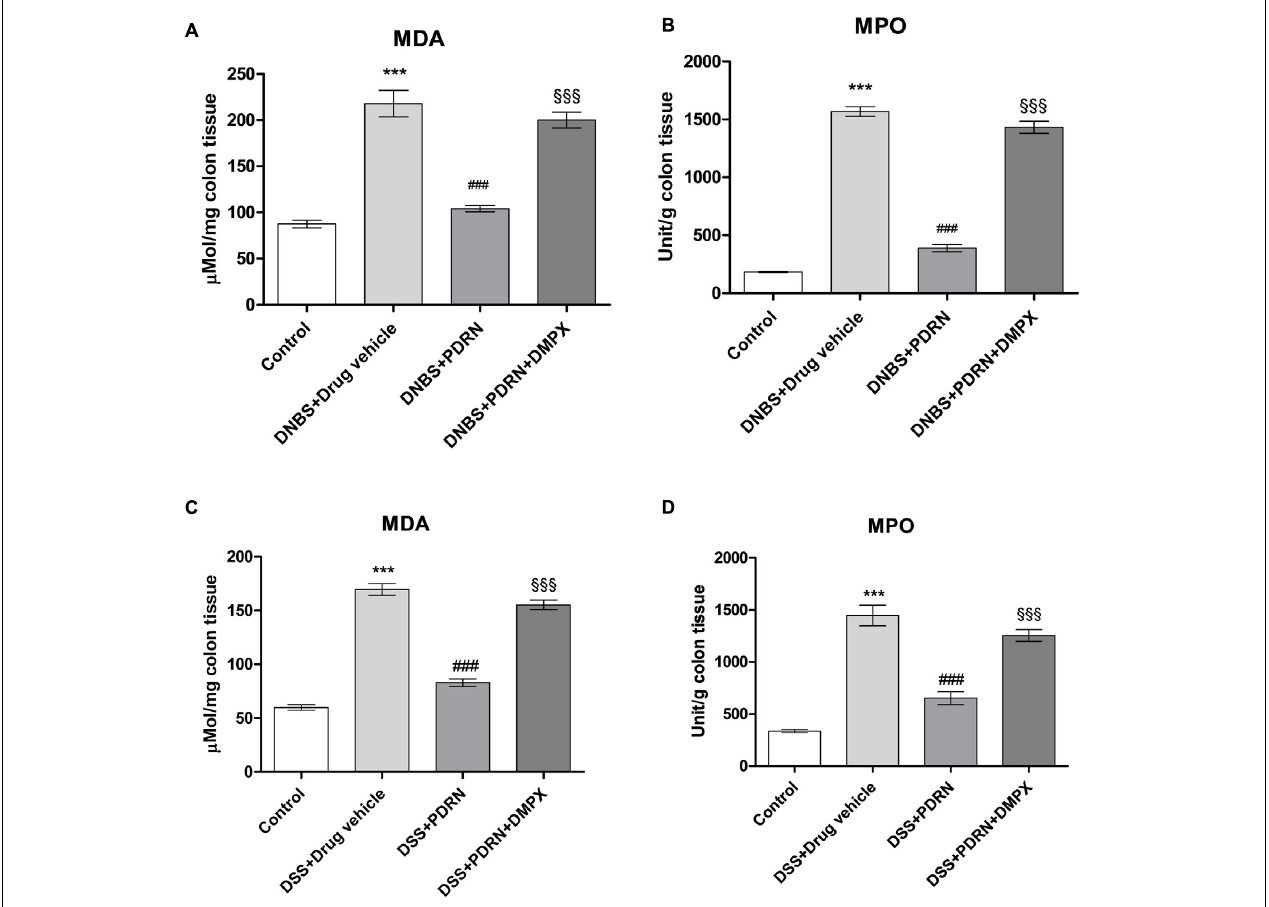
FIGURE 9 | Evaluation of inflammatory markers. The effects of PDRN on malondialdehyde levels and myeloperoxidase activity in DNBS-treated animals are shown in (A) and (B) , respectively, while the consequences of PDRN treatment on malondialdehyde levels and myeloperoxidase activity in the DSS model are summarized in (C) and (D) , respectively. All values are expressed as means and SEM based on observations made on seven animals per group. ∗∗∗ p < 0.0001 vs control group; ### p < 0.0001 vs DNBS/DSS + drug vehicle group; §§§ p < 0.0001 vs DNBS/DSS + PDRN